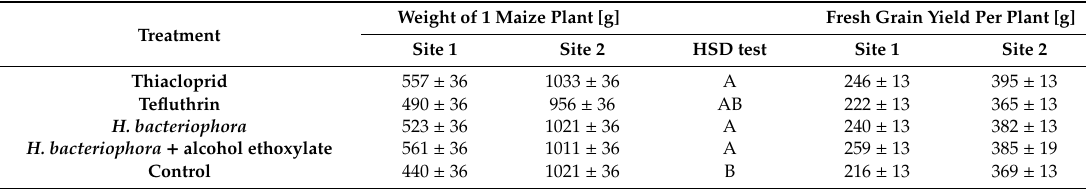
Table 4. E ff ect of di ff erent treatments on fresh plant weight and fresh grain yield per plant. Yield was assessed by weighing ears (fresh, with husks) from five plants. Data presented are averages ± standard error ( n = 20 for all treatments, except n = 15 for H. bacteriophora + alcohol ethoxylate). Treatments not sharing the same letters are significantly di ff